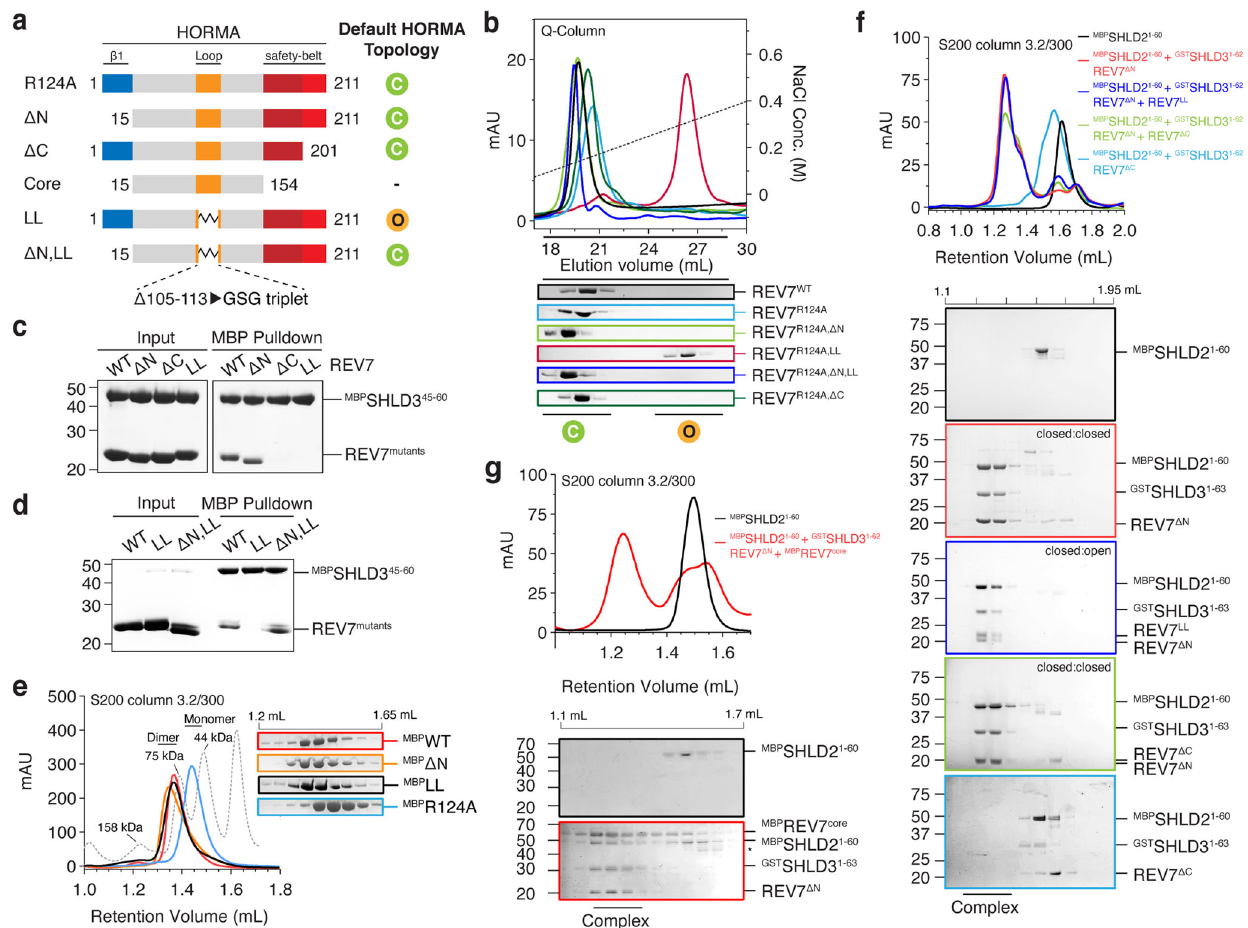
Fig. 3 Shieldin assembly requires only one ‘ closed ’ conformer in REV7 dimer. a Schematic drawing of REV7 constructs used in this study to trap REV7 in different topologies. Different colors correspond to different regions of REV7 which are as follows; blue corresponds to residue 1 – 14, orange (105 – 113), brick red (155 – 201) and red (202 – 211). b Anion-exchange chromatography separates monomeric ‘ closed ’ REV7 from ‘ open ’ REV7. REV7, REV7 Δ N , and REV7 Δ C elute in the ‘ closed ’ conformation. REV7 LL elutes in the ‘ open ’ REV7 conformation, which can be restored to the ‘ closed ’ conformation by the additional removal of the N-terminal 14 residues of REV7 (REV7 Δ N,LL ). The R124A dimerization mutant eliminate potential contributions of dimerization. Eluted fractions were collected and analysed by SDS-PAGE. c MBP-SHLD3 45 – 65 pulldown showing safety-belt interaction between SHLD3 45 – 65 with ‘ closed ’ REV7 mutants. ‘ Open ’ REV7 (REV7 LL ) and seat-belt (REV7 Δ C ) mutants fail to bind SHLD3 45 – 60 . d MBP-SHLD3 45 – 65 pulldown showing that REV7 LL cannot bind SHLD3, however the binding can be restored by the additional removal of the N-terminal 14 residues of REV7 (REV7 Δ N,LL ). e REV7 ‘ conformer ’ mutants (MBP-tagged) elute as dimers from size-exclusion column. The R124A mutant prevents dimerization and serves as monomer control. The consecutive 50 µ L fractions eluting from 1.2 and 1.65 mL are shown. f Size-exclusion chromatography pro fi les show interaction between equimolar ratios of MBP- SHLD2 1 – 60 , REV7 Δ N/ Δ C , GST-SHLD3 1 – 62 , and REV7 Δ N/ Δ C/LL . Samples were analysed by SDS-PAGE. g Size-exclusion chromatography pro fi les show interaction between MBP-SHLD2 1 – 60 , REV7 Δ N , GST-SHLD3 1 – 62 and MBP-REV7 core . MBP-SHLD2 1 – 60 and MBP-REV7 core were loaded in excess. Samples were analysed by (Fig. S2a). The conversion between conformers is de fi ned by